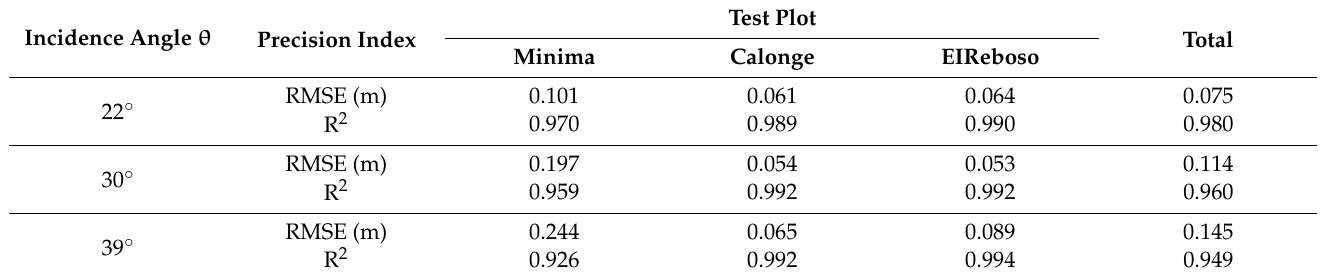
Incidence Angle